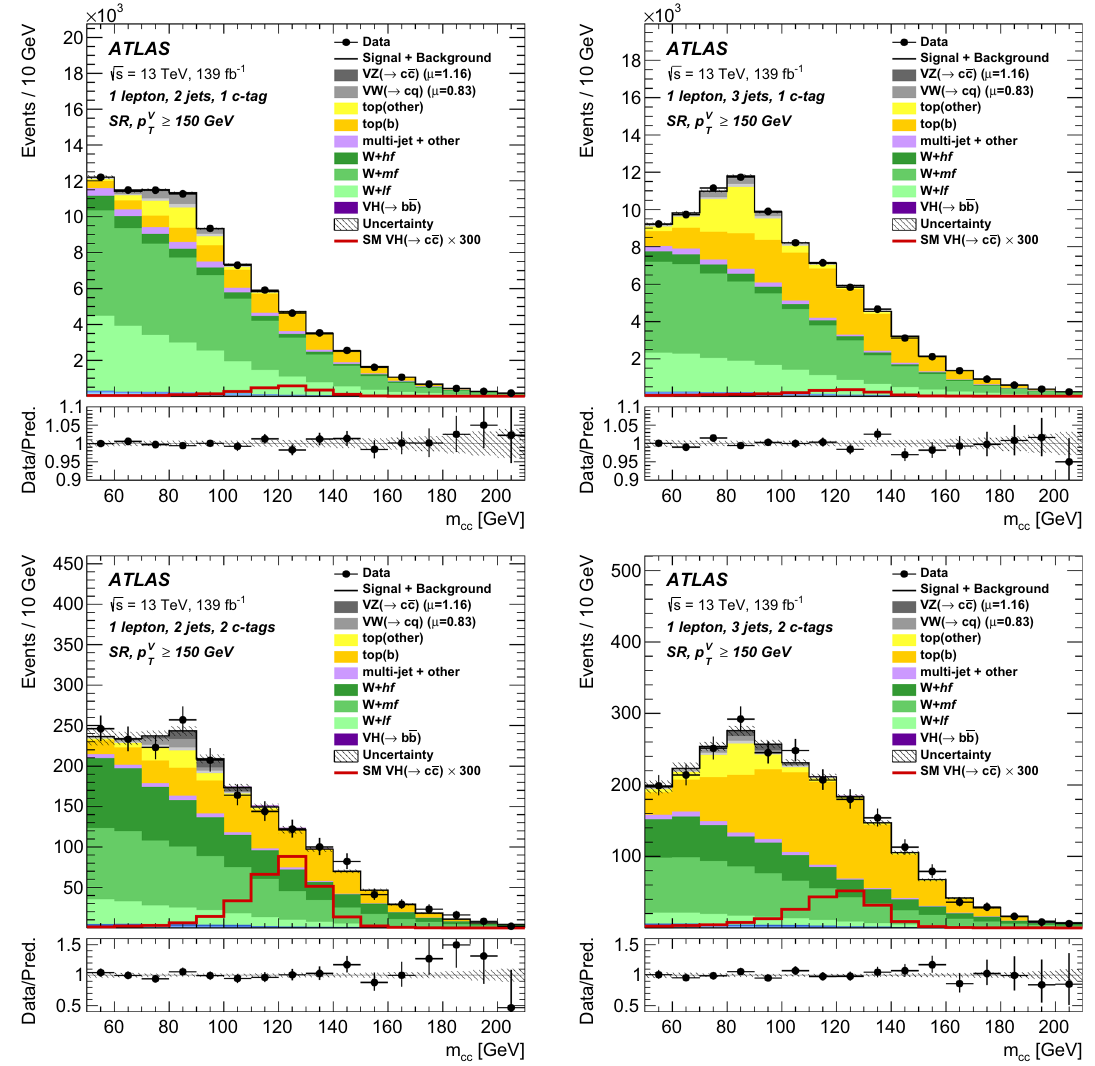
Fig. 9 Post-fit distributions of the four 1-lepton signal regions. The total signal-plus-background prediction is shown by the solid black line and includes the H → c ¯ c signal scaled to the best-fit value of μ = − 9. The H → c ¯ c signal is also shown as an unfilled his- VH ( c ¯ c )